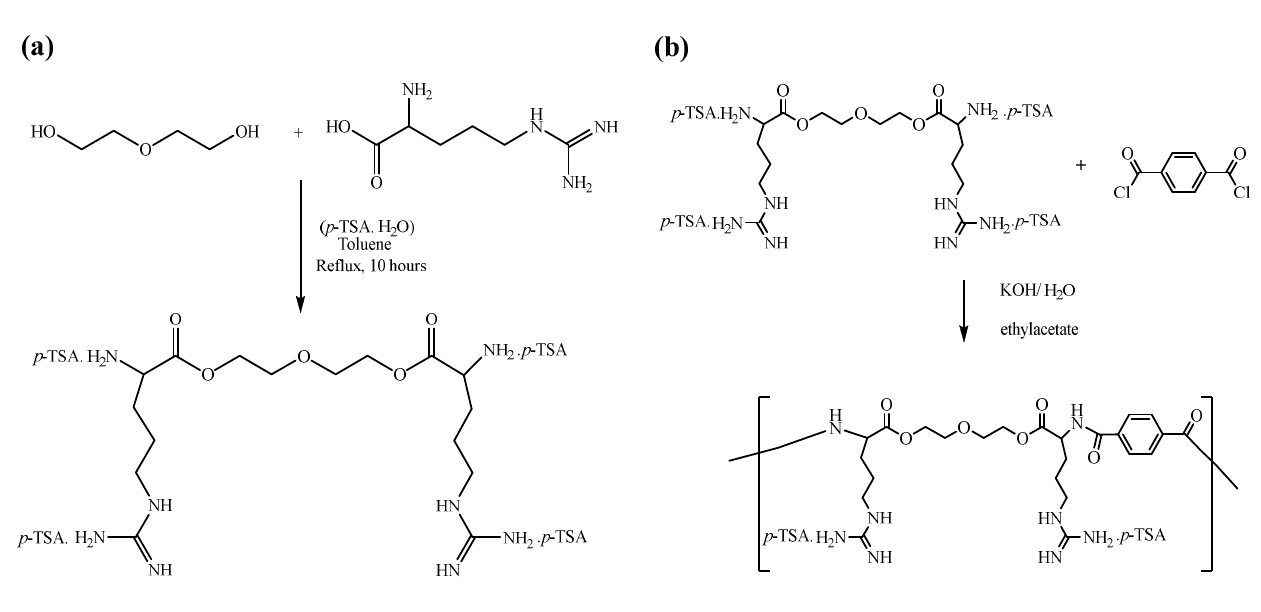
Figure 1. ( a ) Synthesis of di- p -toluenesulfonic acid salt of O,O’-bis-(L-arginine)-diethylene glycol monomer. ( b ) Synthesis of poly(ester amide)s by interfacial polycondensation of di- p -toluenesulfonic acid salt of O,O’-bis-(L-arginine)- diethylene glycol monomer.